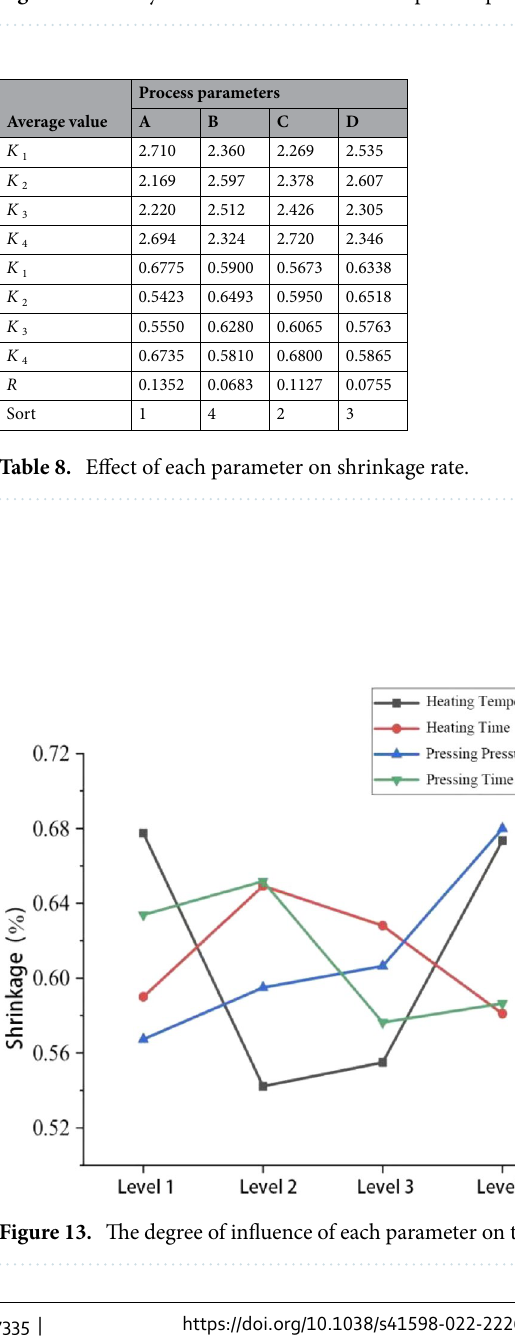
Figure 12. Analysis results under A3B3C1D4 process parameter combination.